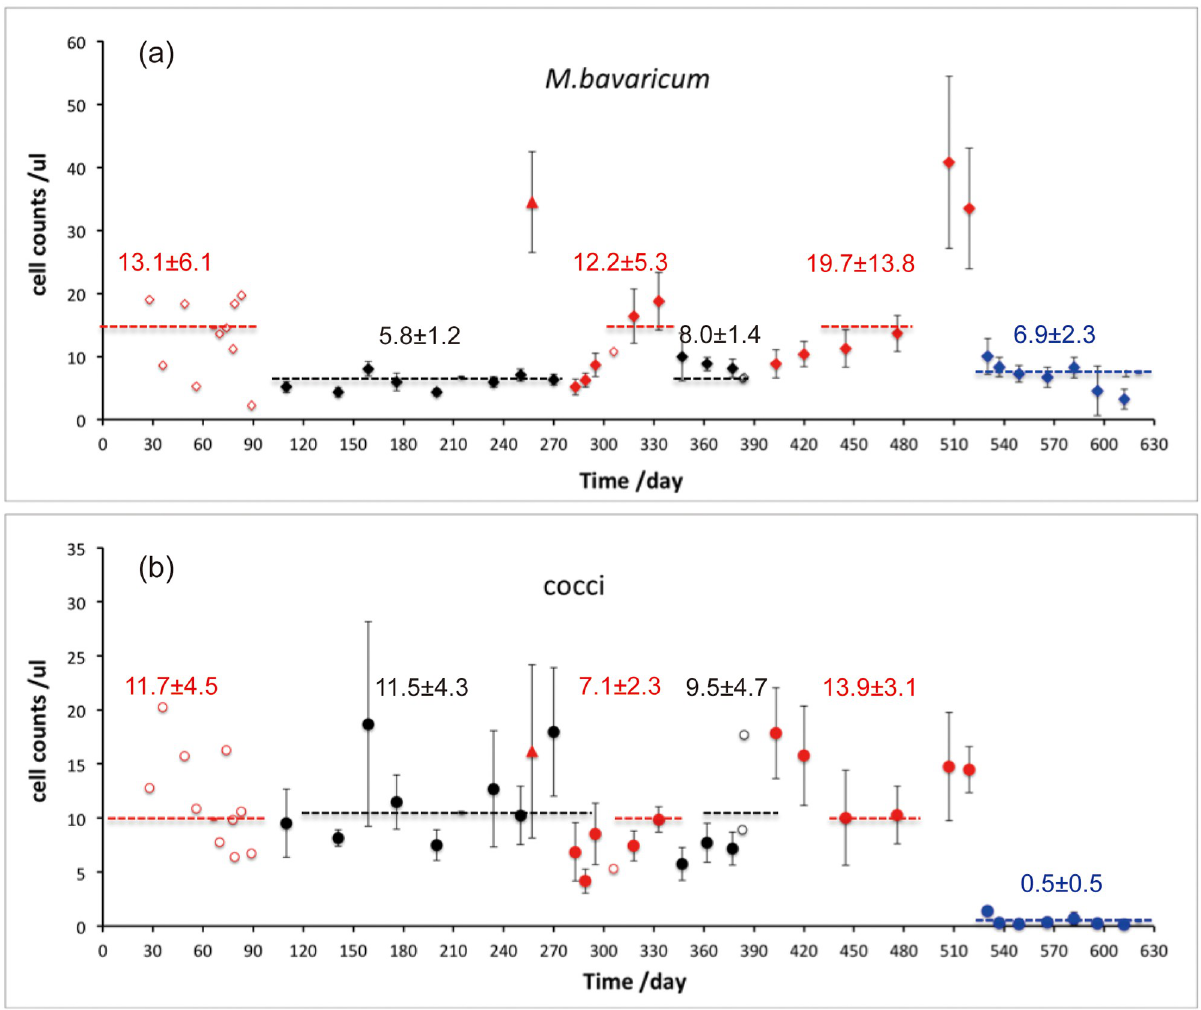
Fig 6. Population changes of M . bavaricum (a) and cocci (b) in Earth’s field (red symbols), zero field (black symbols) and alternating field (blue symbols) as a function of time. Filled symbols represented averaged population density of 6–9 profiles (25 mm long) and smaller open symbols represented population density of single profile. Horizontal dashed lines and numbers errors referred to mean concentration in zero field (black), Earth’s field (red) and alternating field (blue). Red filled triangle represents one sediment microcosm constantly in Earth’s field.